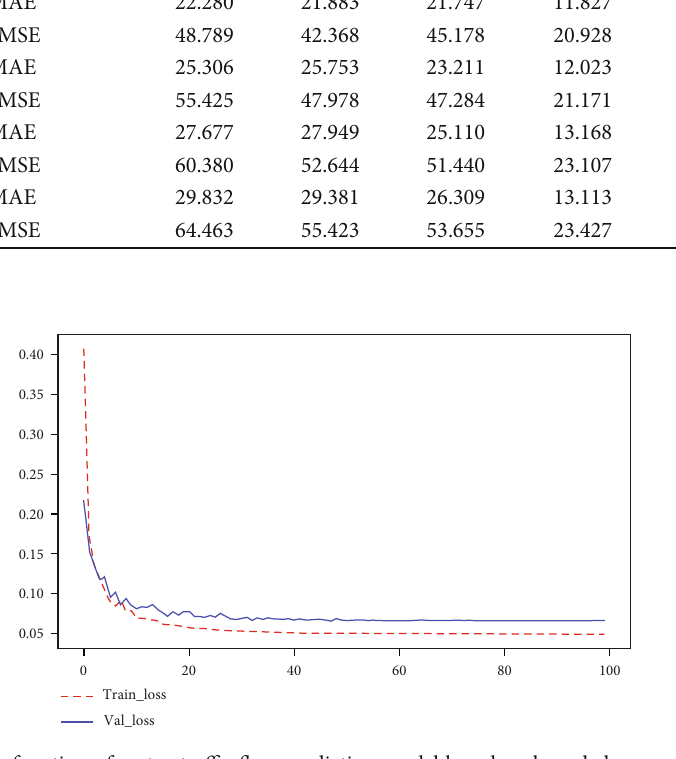
Figure 7: The change of loss function of metro tra ffi c fl ow prediction model based on knowledge graph representation